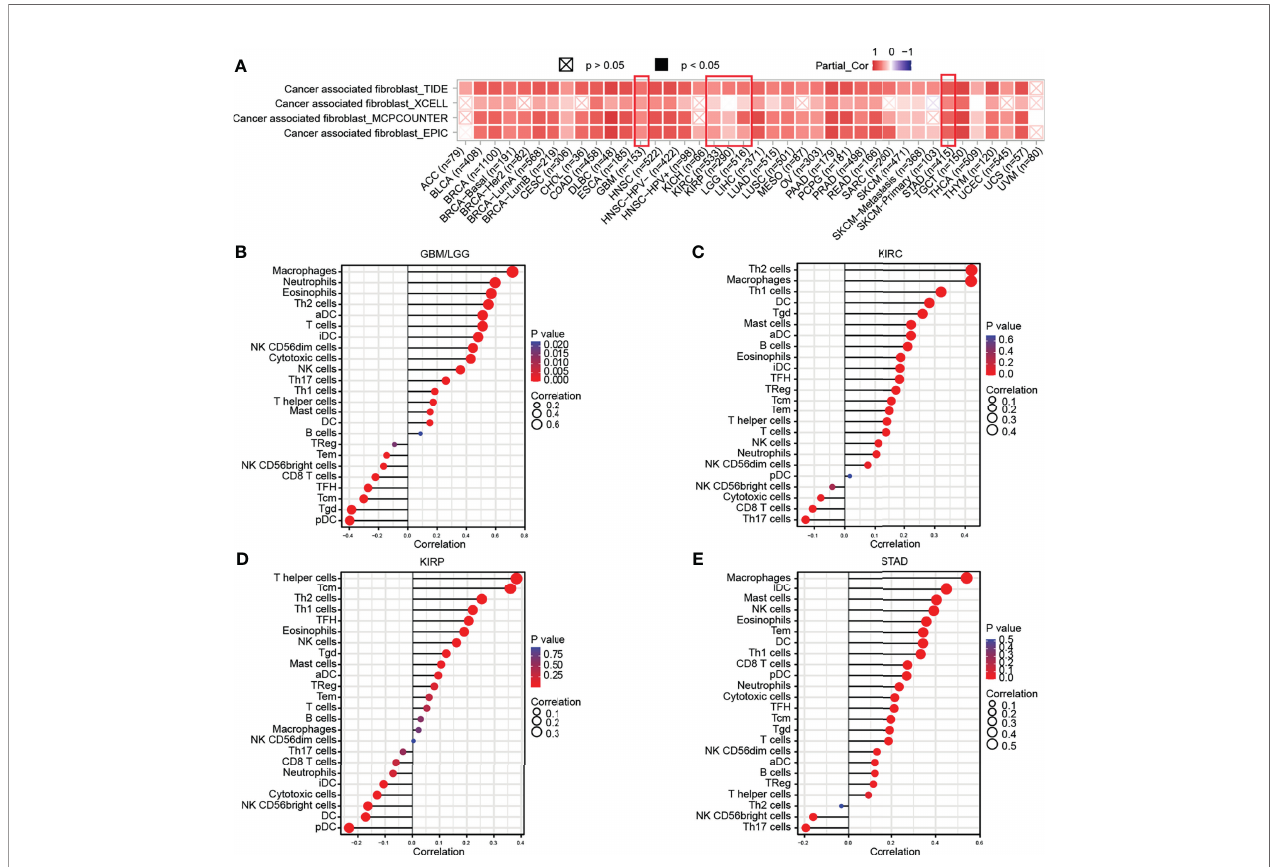
FIGURE 5 | Correlation analysis between GPX8 expression and tumor-in fi ltrating immune cells. (A) Correlation analysis between GPX8 expression and CAFs in pan- cancer (http://timer.comp-genomics.org/). (B – E) Correlation analysis between GPX8 expression and immune cells in GBM/LGG, KIRC, KIRP,